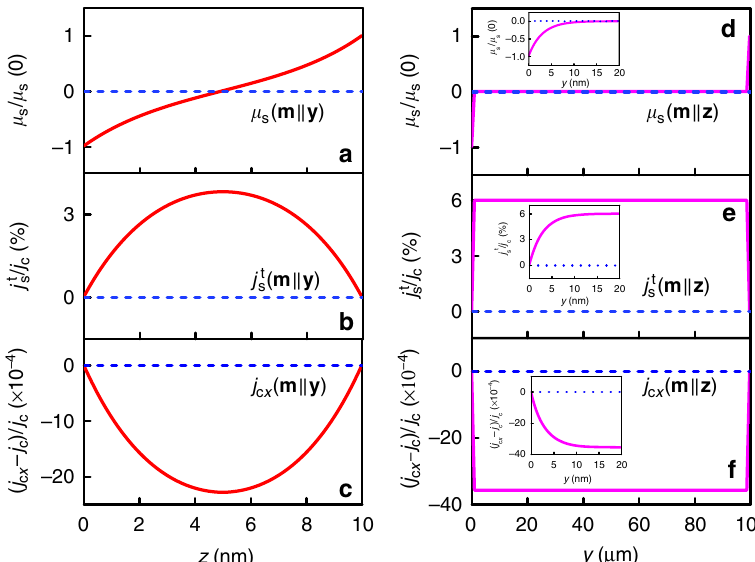
Fig. 4 Modulation of the spin accumulation, transverse spin current, longitudinal charge current by AHE in FM. a – c normalized distributions along z -direction for the cases of m || y : a spin accumulation μ y -direction for the cases of m || z : d spin accumulation μ when no AHE is present in the sample. Insets of d – f are the distributions near the vicinity of the